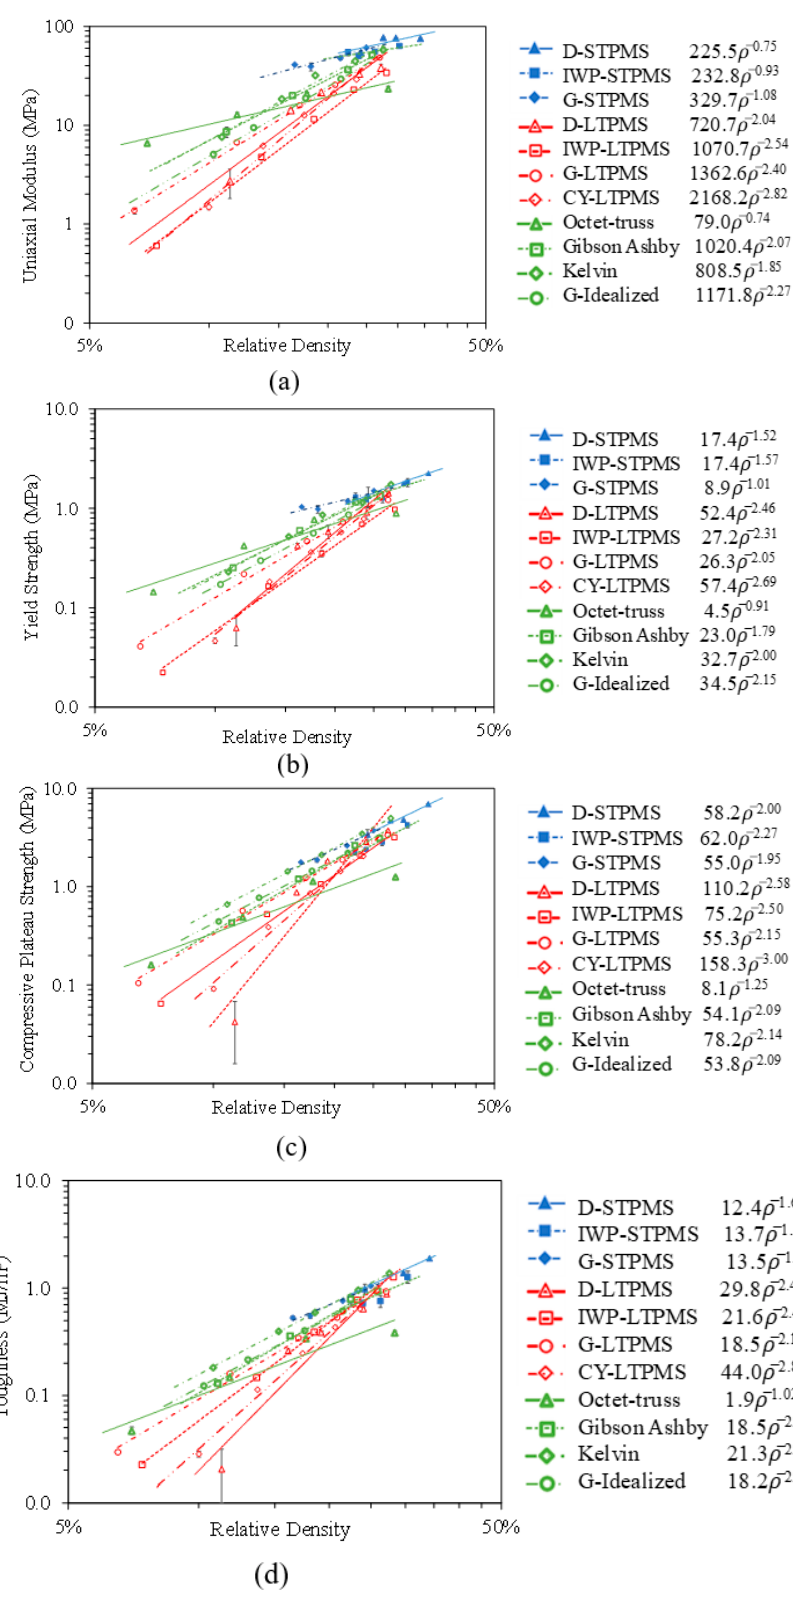
Figure 8. Deduced mechanical properties of different architectural topologies fitted with the Gibson–Ashby power scaling law: ( a ) uniaxial modulus, ( b ) yield strength, ( c ) plateau strength, and ( d ) toughness up to 40%